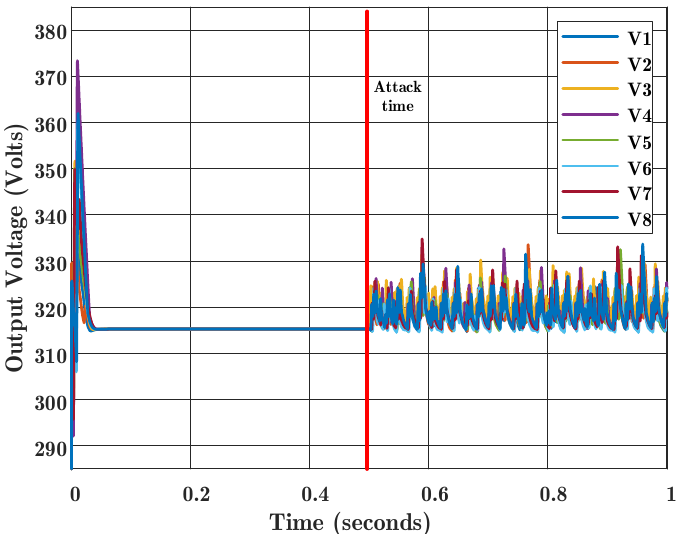
Figure 6. Output voltages of boost converters for conventional consensus algorithm in the presence of false data injection attack at time 0.5 s. The values of V 1 to V 8 are output voltages for Agent 1 to 8,